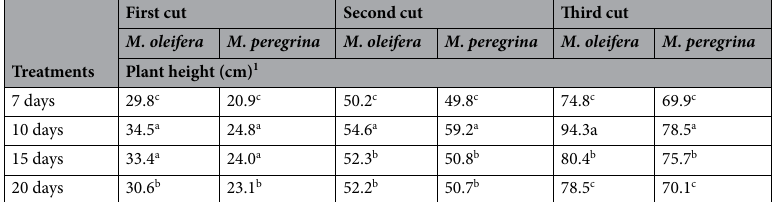
Table 1. The effect of irrigation frequency on plant height of M. oleifera and M. peregrina at different cutting periods. 1 Means within each column with the same superscripts were not significantly different using Duncan Multiple Range Test at the 0.05 level of